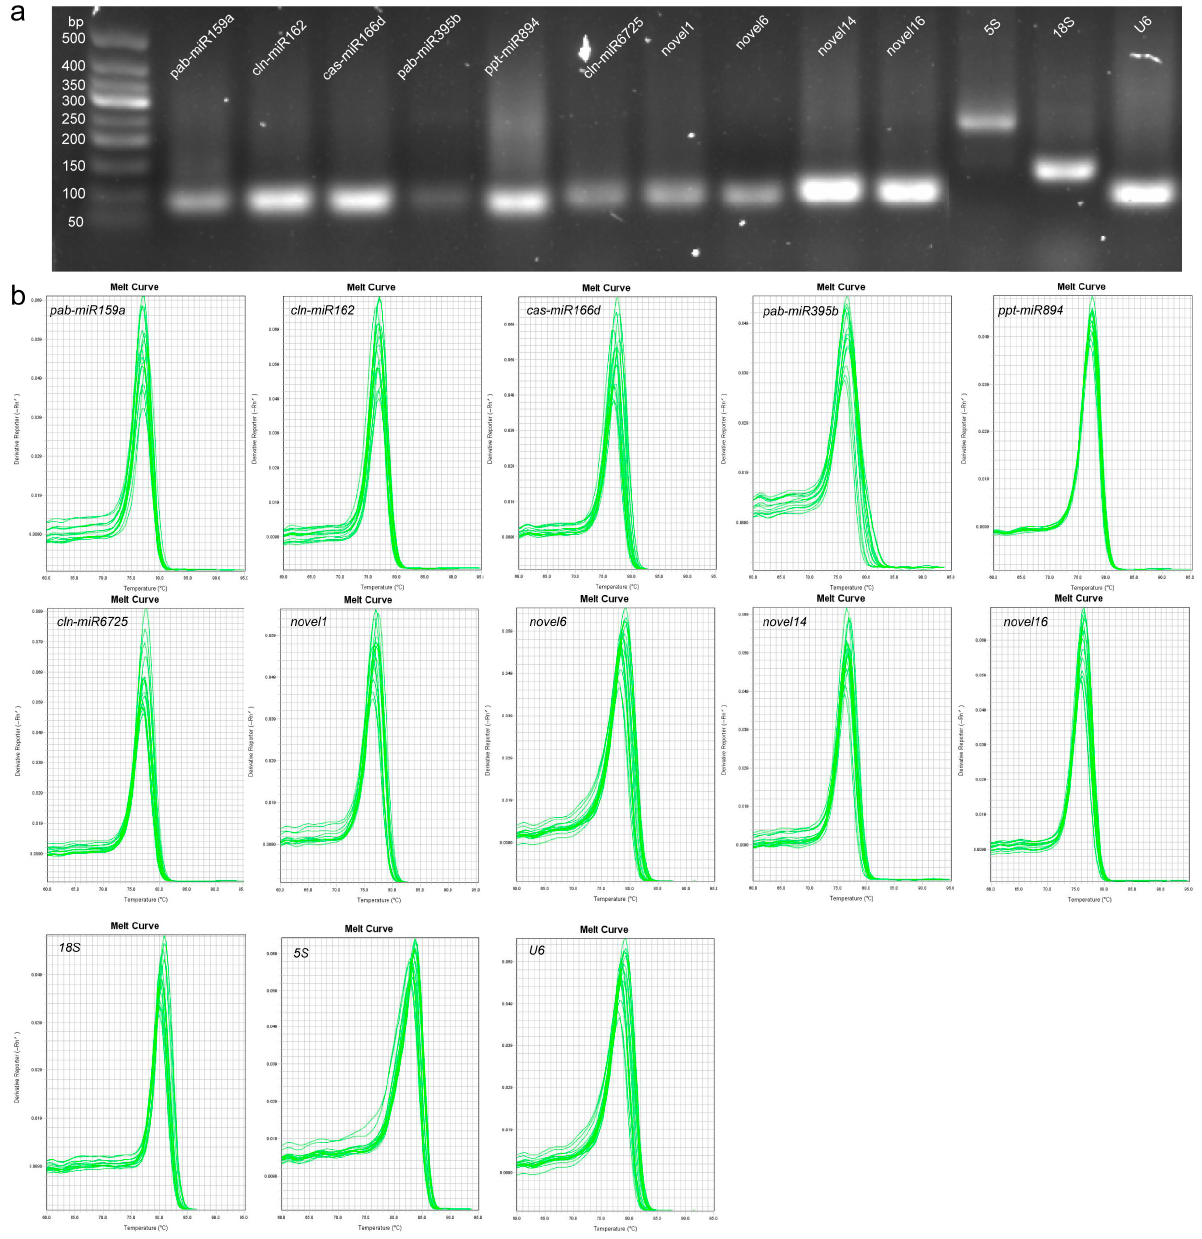
Figure 1. Specificity of each candidate reference gene (RG) primer pair. ( a ) Confirmation of the specificity of qPCR primer amplification of candidate RGs by agarose gel electrophoresis. ( b ) Melting-curve analysis of quantitative real-time PCR (qRT-PCR) amplification of 13 candidate RGs in Cryptomeria fortunei .